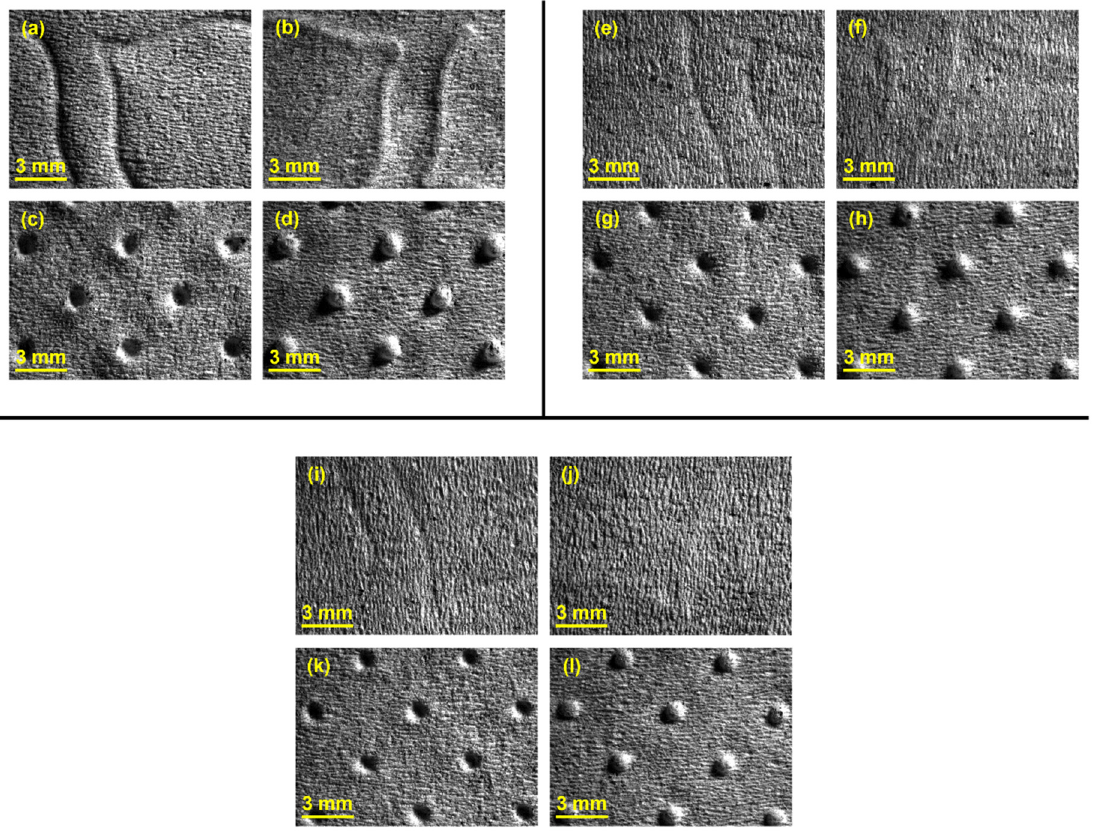
Figure 6. Global views of tissue paper embossed with the different rubber hardness using configuration 1: ( a ) 48 Sh-A (deco—front side); ( b ) 48 Sh-A (deco—back side); ( c ) 48 Sh-A (micro—front side); ( d ) 48 Sh-A (micro—back side); ( e ) 60 Sh-A (deco—front side); ( f ) 60 Sh-A (deco—back side); ( g ) 60 Sh-A (micro—front side); ( h ) 60 Sh-A (micro—back side); ( i ) 75 Sh-A (deco—front side); ( j ) 75 Sh-A (deco—back side); ( k ) 75 Sh-A (micro—front side); and ( l ) 75 Sh-A (micro—back side).